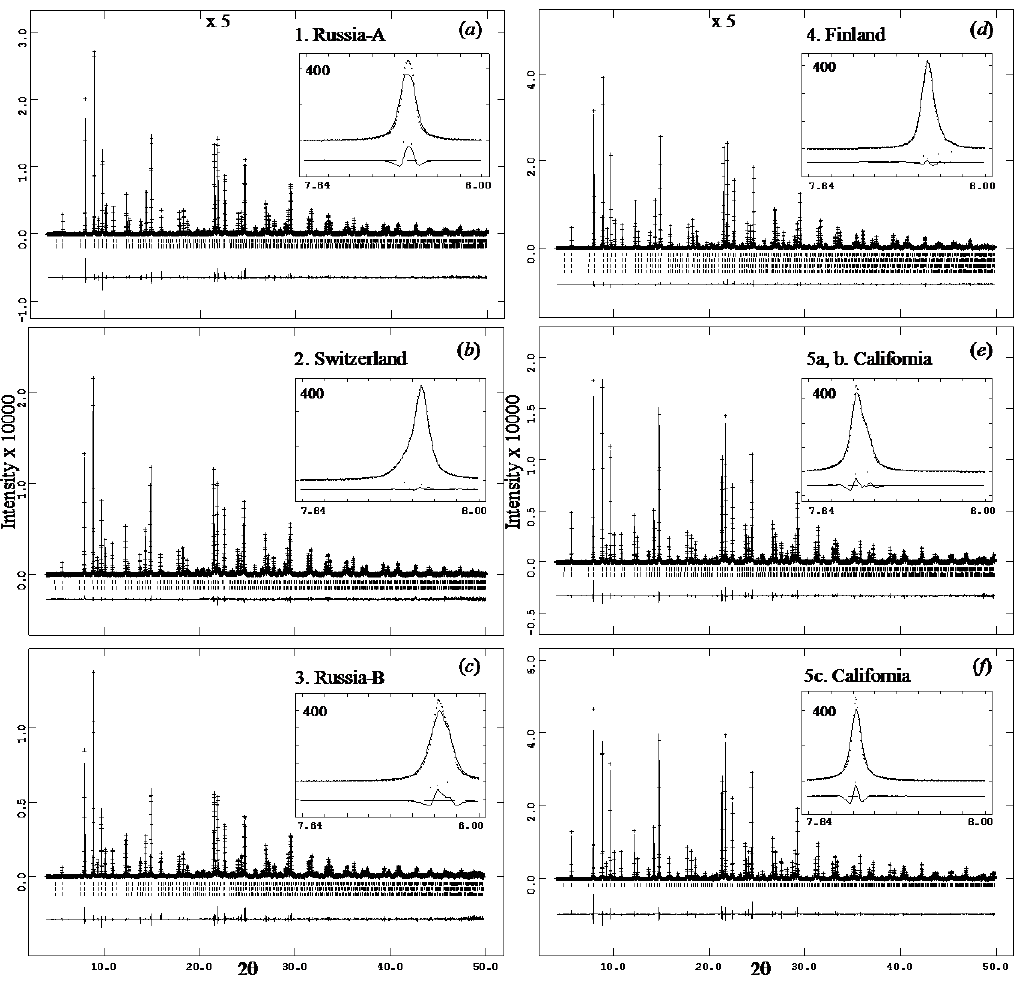
Figure 7. Complete HRPXRD traces for the five Uv samples: ( a ) 1. Russia-A, ( b ) 2. Switzerland, ( c ) 3. Russia-B, ( d ) 4. Finland, ( e ) 5a, b. California, and ( f ) 5c. California. The di ff erence curve ( I obs − I calc ) is shown at the bottom of each trace. Short vertical lines indicate allowed reflection positions. The intensities and di ff erence curves that are above 20 ◦ 2 θ are multiplied by 5. The inserts contain the 400 reflection that occurs at a low 2 θ angle, and the range is the same for each sample.